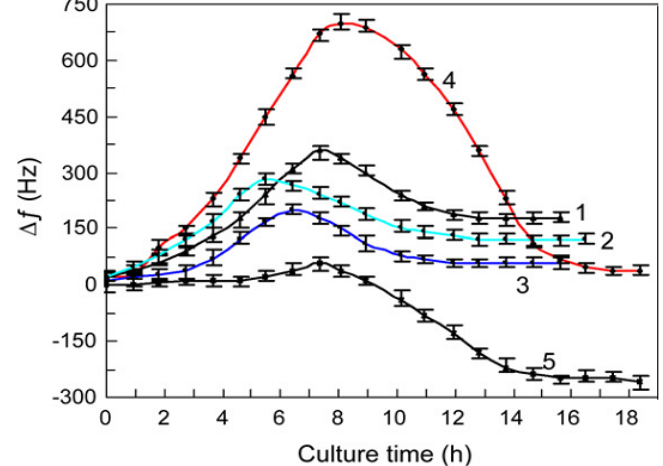
Figure 27. Change in resonance frequency as a function of time of a magnetoelastic sensor with the growth of different microbes in milk: (1) E. coli ; (2) S. epidermidis ; (3) P. aeruginosa ; (4) P. aureus ; (5) Blank. Reprinted with permission from